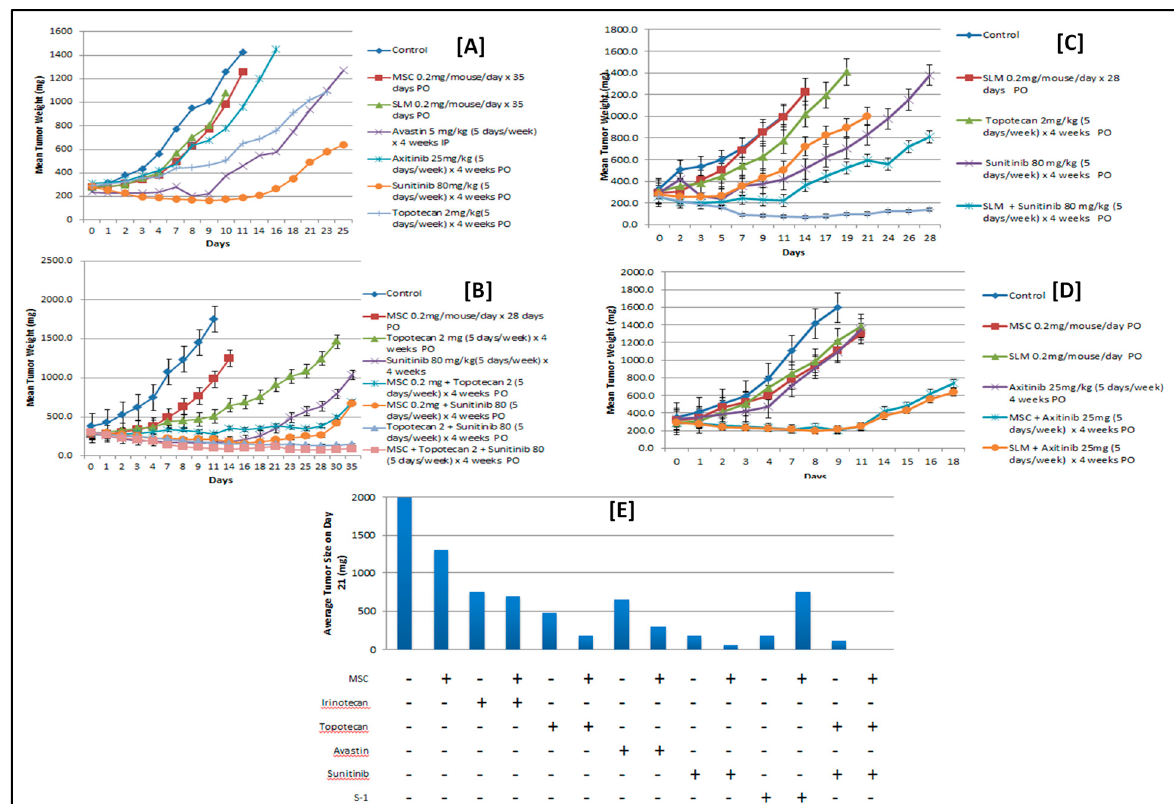
Figure 7. Pretreatment of 786.0 xenografts expressing HIF2 α with a nontoxic but molecularly effective dose of MSC sensitizes tumor cells to subsequent treatment with the combination of VEGF/VEGF receptor (VEGFR)-targeted agents and chemotherapy. Assessment of antitumor activity of MSC, SLM, Avastin, axitinib, sunitinib, and topotecan, administered individually to nude mice bearing 786.0 ccRCC tumors ( A ), and in combination with either MSC ( B ) or SLM ( C ), and in combination with axitinib ( D ). ( E ) Summary of the antitumor activity of MSC in sequential combination with anticancer therapies [83].